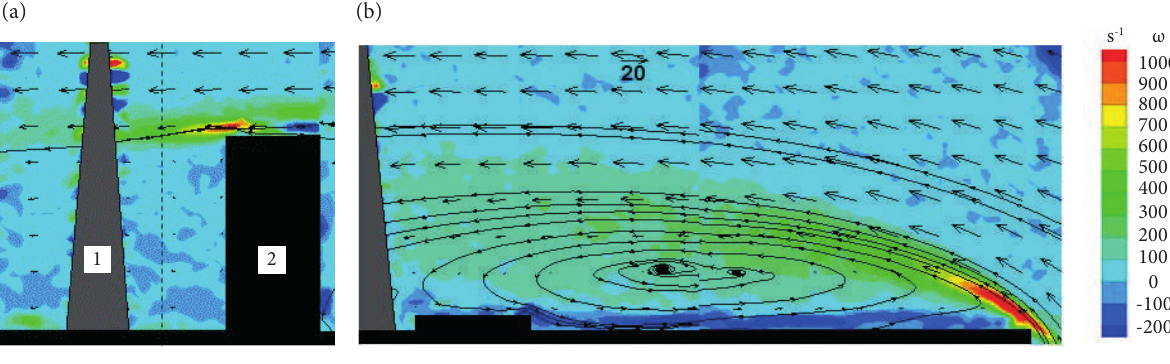
Figure 12. Vorticity contours and velocity vectors – β = 90°, α = 0° and Re = 4.3 × 10 5 . (a) Neighborhood